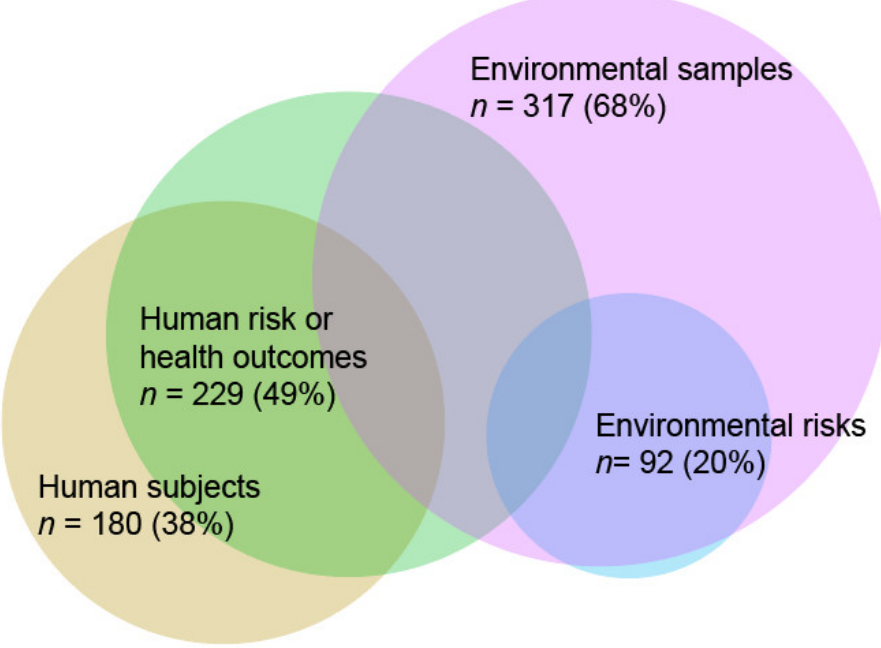
Figure 3. Venn diagram (number of study sites (%)) showing the proportional overlaps between environmental samples, human subjects (i.e., involving any human participants), health outcomes and risks and environmental risk assessments ( n = 469).